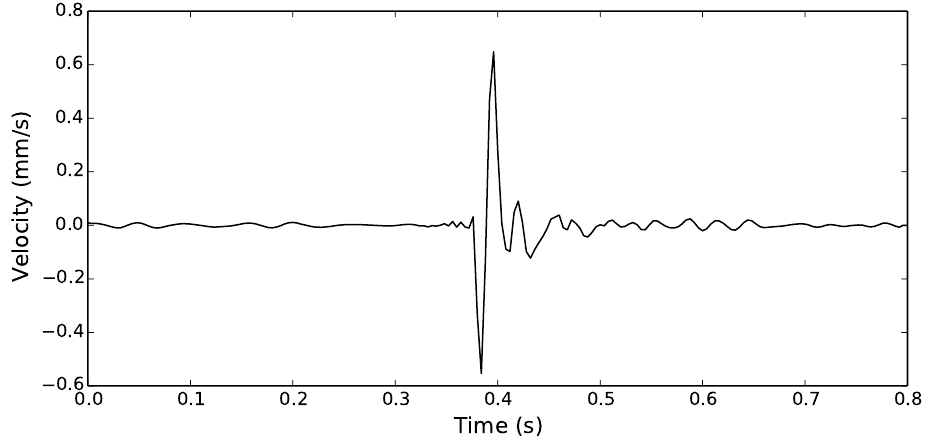
Figure 8. Time recording of the calibrated stroke at a distance of 1 m from the BRS32 seismic station.